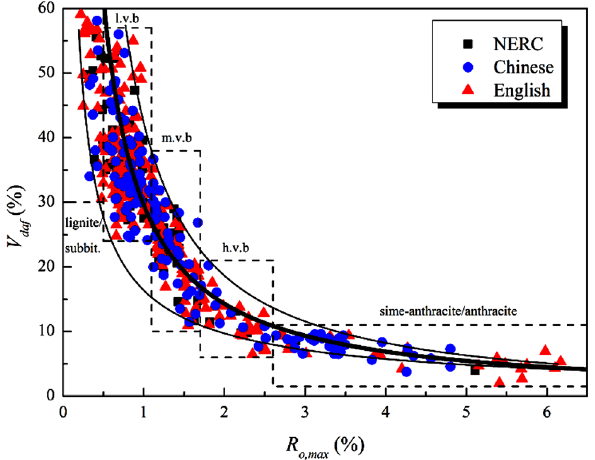
Fig. 5 Variation of V daf with vitrinite reflectance R o ; max . (Data size: NERC-189, Chinese (Yu et al. 2004; Chang et al. 2006; Qin et al. 2007; Chang et al. 2008; Chen et al. 2010; Hao et al. 2012;